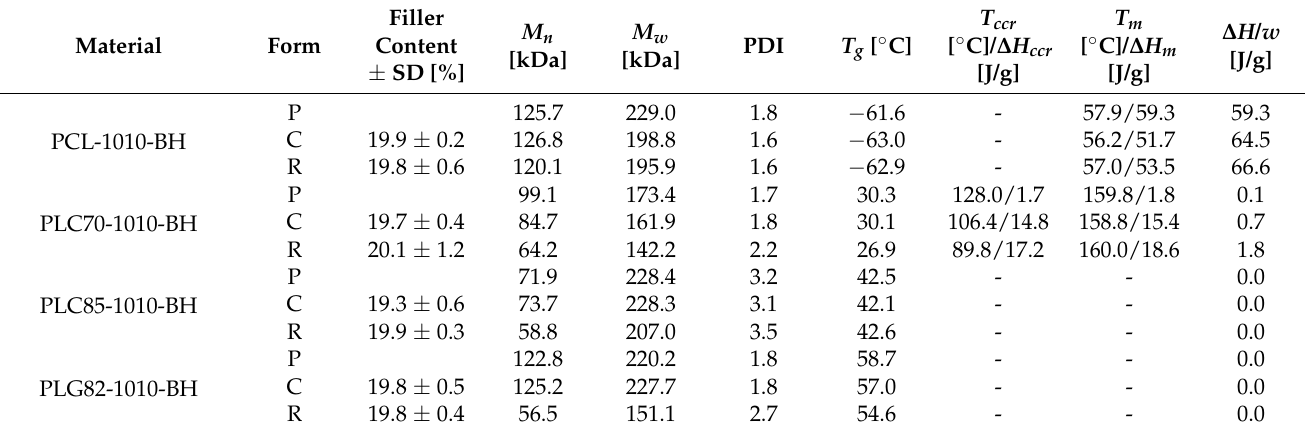
Table 1. The results of the characterisation of materials in the form of: P—raw polymer, C—solvent cast composite plate, R—thermally extruded rods. TGA: filler content; GPC: M n —number average